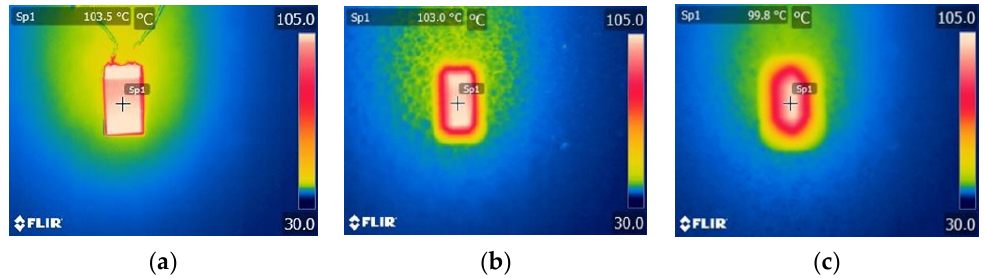
Figure 1. Thermograms of Pt1000 temperature sensor with ϑ p = 103.5 ◦ C = const. The value of ϑ m has been determined at point Sp1. ( a ) ϑ m = 103.5 ◦ C; ( b ) ϑ m = 103.0 ◦ C; ( c ) ϑ m = 99.8 ◦ C.